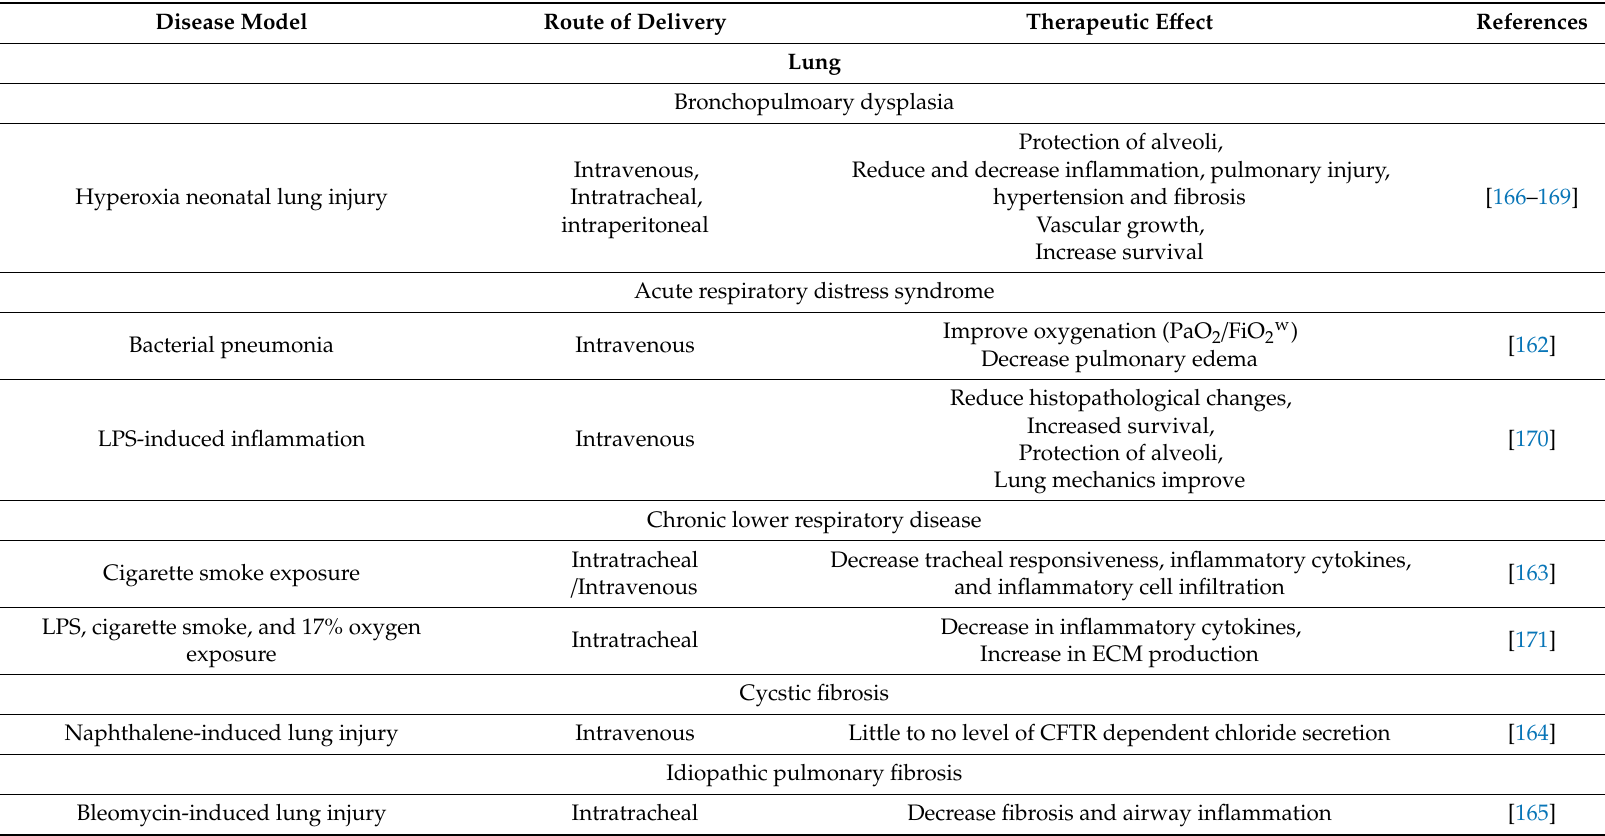
Table 3. E ff ect of mesenchymal stem cells in fibrosis-related disease animal